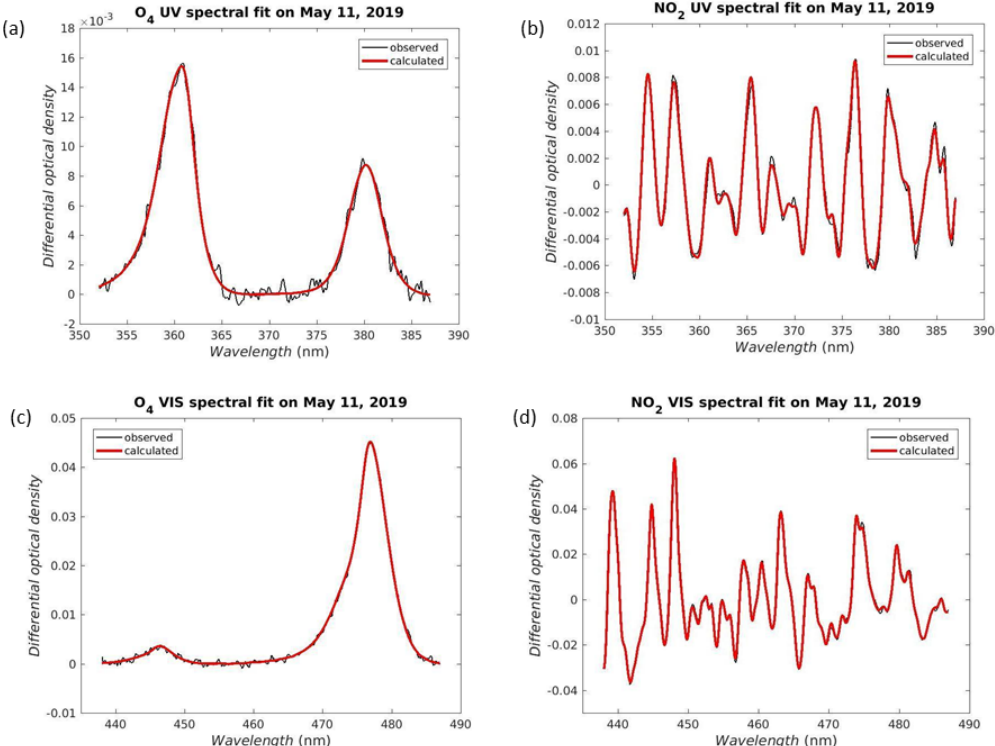
Figure 3. Spectral detection of O 4 (a) and (c) and NO 2 (b) and (d) . Red lines represent the calculated optical densities, and black lines are the measured optical densities. The viewing geometry of each detection was (a) VEA 2 ◦ and solar zenith angle, SZA, 26.4 ◦ , (b) VEA 3 ◦ and SZA 24.7 ◦ , (c) VEA 1 ◦ and SZA 22.6 ◦ , and (d) VEA 1 ◦ and SZA 48.7 ◦